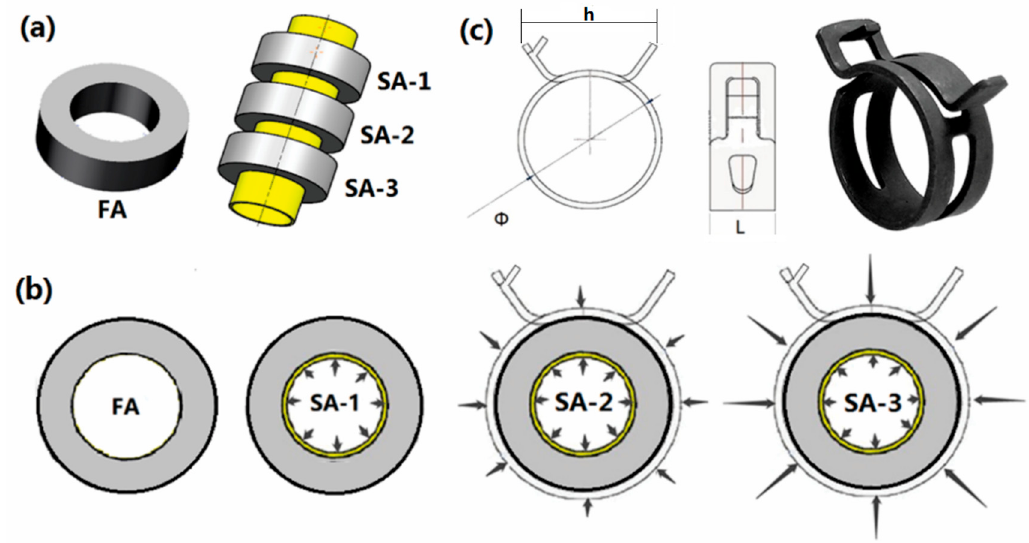
Figure 1. ( a , b ) Schematic representations of the four categories of samples (FA, SA-1, SA-2, and SA-3) prepared to apply various extents of stress. ( c ) An illustration of the spring band clamp utilized to apply radial stresses on the as-wound cores. The bandwidth of clamps (L) is 12 mm.